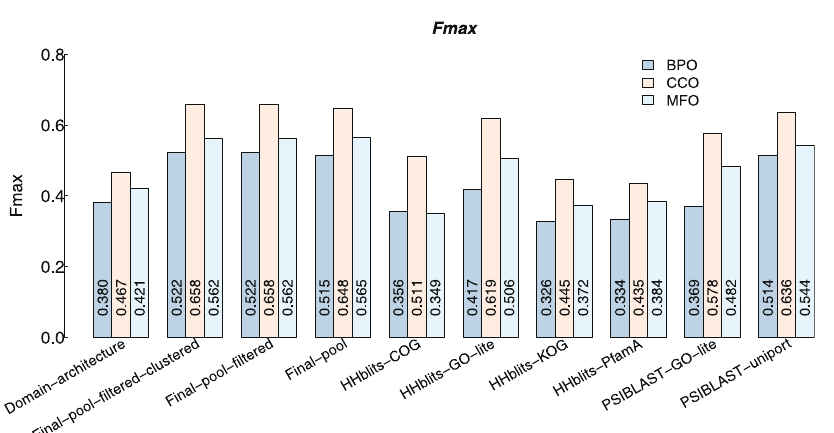
Figure 6. The F max scores of PANDA and other seven predictors. It can be found that the different steps of filtering and combining baseline predictors of PANDA (starting with Final-) achieve slightly higher performance than PSI-BLAST-uniprot, but significant higher than other baseline